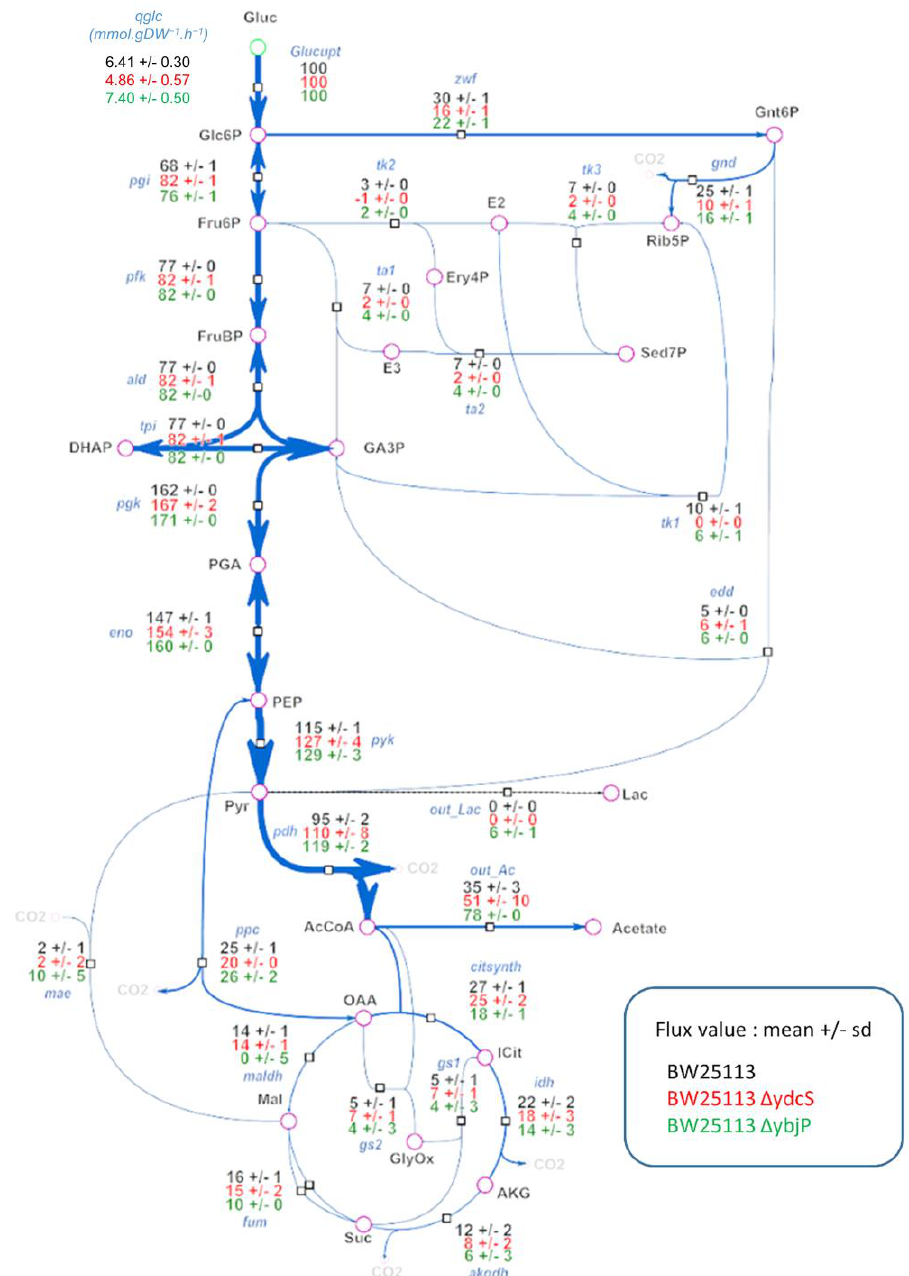
Figure 4. Distribution of metabolic fluxes in Δ ydcS and Δ ybjP strains. A: Intracellular flux distributions in the two mutant strains and comparison with the WT strain. All fluxes are expressed relative to the glucose uptake rate, set arbitrarily to 100 for each strain. The absolute glucose uptake rates (mmol.gDW − 1 · h − 1 ) of the three strains are shown in the top left of the figure. Significant alterations of fluxes in the Tricarboxylic Acid Cycle (TCA) cycle and re- lated pathways were observed in the two mutant strains compared to the wild-type strain.